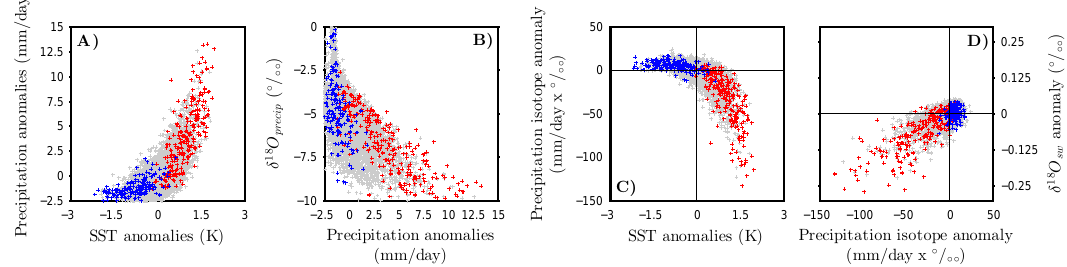
Fig. 5. Scatter plots of the relationships between (A) the inter-annual monthly anomalies of precipitation with SST, (B) the monthly inter-annual anomalies of precipitation and the isotopic composition of that precipitation ( δ 18 O precip ), (C) the product of the precipitation anomalies and δ 18 O precip , referred to as the precipitation isotope anomaly, with SST and (D) the precipitation isotope anomaly and the δ 18 O sw anomalies seen in the Western Cold Tongue box (the location of which is shown on Figs. 2, 4). The data points are color-coded according to the corresponding NINO3 SST anomalies, with the upper ten percentiles shown in red (eastern Pacific El-Ni˜no type conditions) and the lower ten percentiles in blue (eastern Pacific La-Ni˜na type conditions).